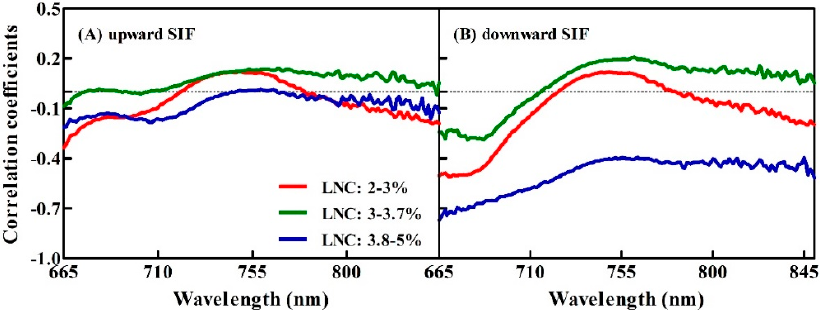
Figure 5. Correlation coefficients between the upward, downward SIF spectra and the three different ranges of